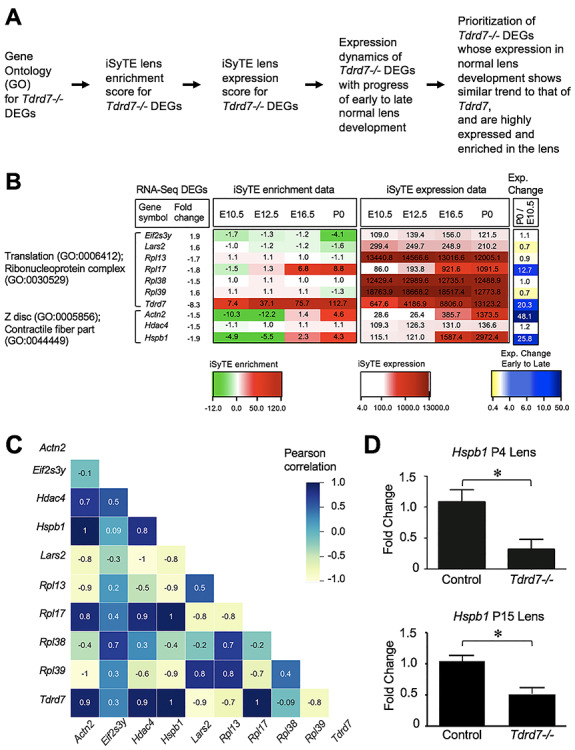
iSyTE-based analysis of Tdrd7−/− lens RNA-Seq data identifies Hspb1 among the high-priority candidates. (A) Flowchart of analysis of RNA-Seq data for the identification of high-priority candidate genes in Tdrd7−/− lens. (B) An integrated analysis using iSyTE lens expression and enrichment data along with functional annotation and GO enrichment of significant (FC ±1.5, P-value ≤ 0.05) RNA-Seq differentially expressed genes (DEGs). GO categories for DEGs are indicated on the left. iSyTE-based expression and enrichment data at normal embryonic and postnatal lens development stages (E10.5, E12.5, E16.5 and P0) for the Tdrd7−/− lens DEGs are represented in the heat map diagram using ‘red–white–green’ and ‘red–white–white’ color gradients, respectively. Lens expression of DEGs at early postnatal stage P0 over that at early embryonic stage E10.5 (expression in late versus early lens) is represented using ‘blue–white–yellow’ color gradient. (C) Pearson correlation heat map of candidate genes based on iSyTE wild-type lens expression data across the four developmental stages. The integrated approach outlined in (A–C) applies GO category enrichment as well as iSyTE-based analysis of DEGs and associates Hspb1 as a top priority candidate gene (criteria: expression score in normal lens >2000, enrichment score in normal lens > 4.0, differential expression in Tdrd7−/− lens >1.5-fold change, P-value <0.05). (D) RT-qPCR analysis of Hspb1 validates its downregulation in Tdrd7−/− lenses at stages P4 and P15. Asterisk indicates P-value <0.01.